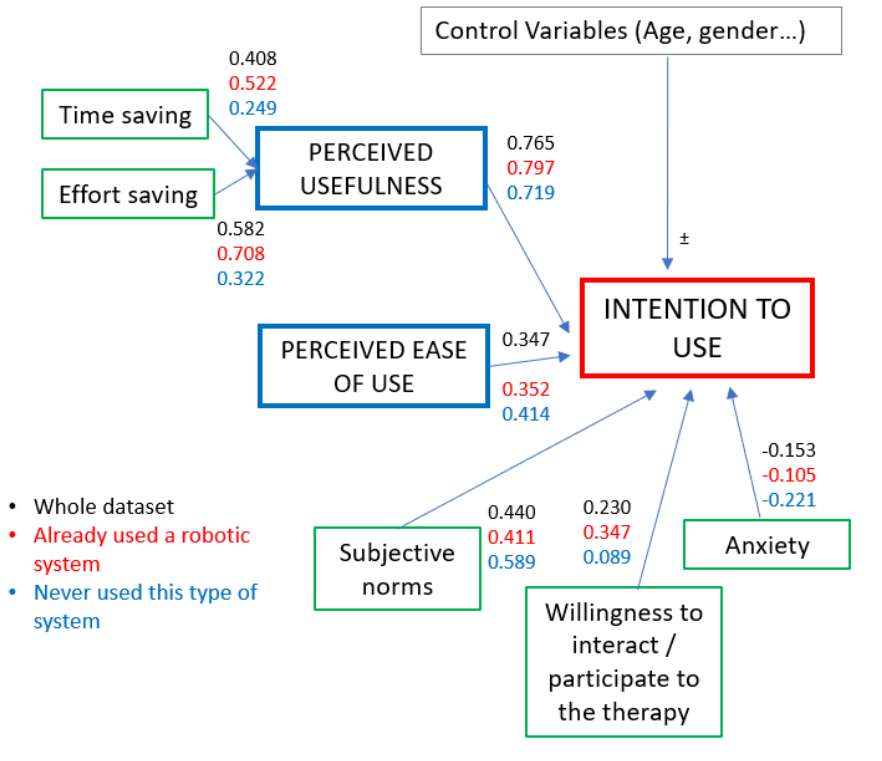
Figure 4. Structure of the TAM with references of the correlations between the various variables involved in the